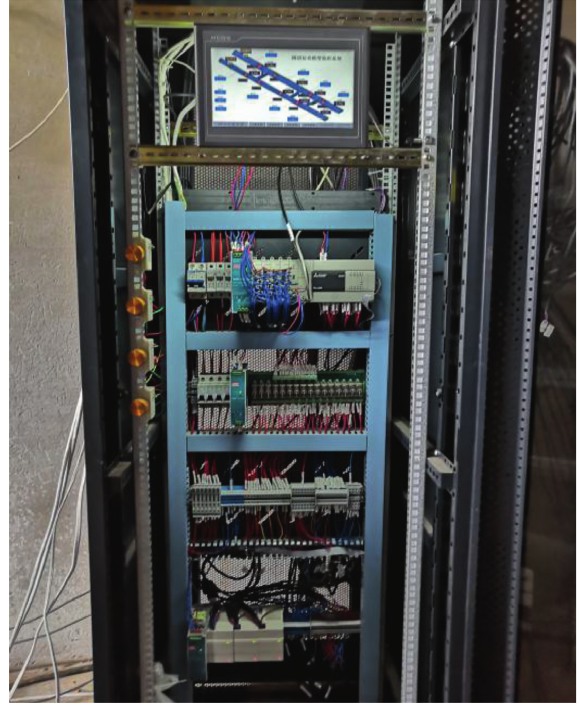
Figure 7: PLC control system.